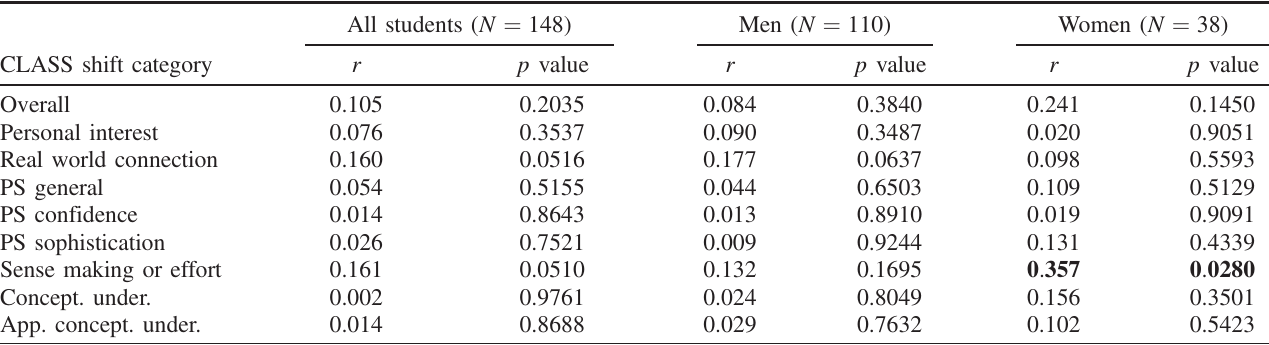
TABLE VI. Correlation of the normalized FCI gain and CLASS shifts, separated by category, for all students, men, and women. The regression coefficient r and the p value are